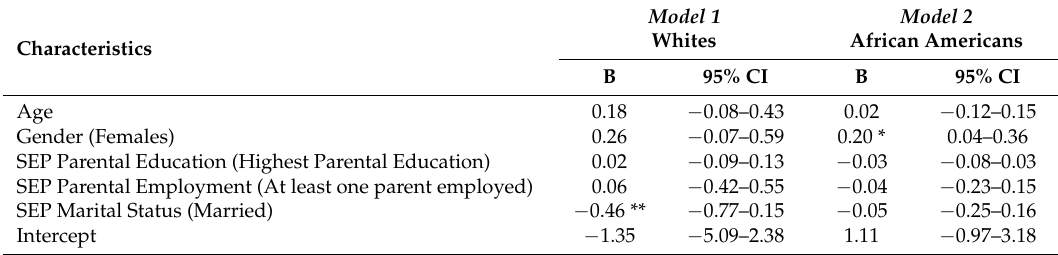
Table 4. Results of linear regression models between marital status (married parents) at wave 1 and symptoms of anxiety at wave 12 in Whites and African